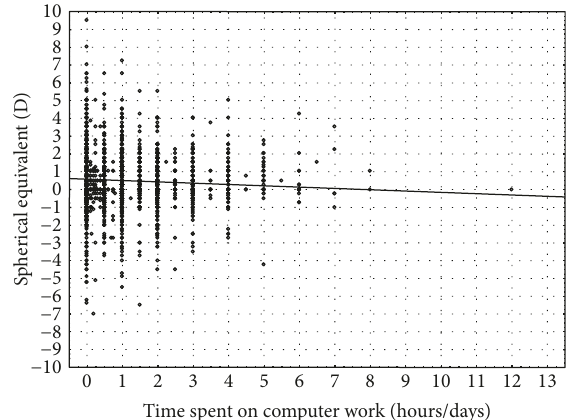
Figure 2: Mean spherical equivalent in relation to using a computer.